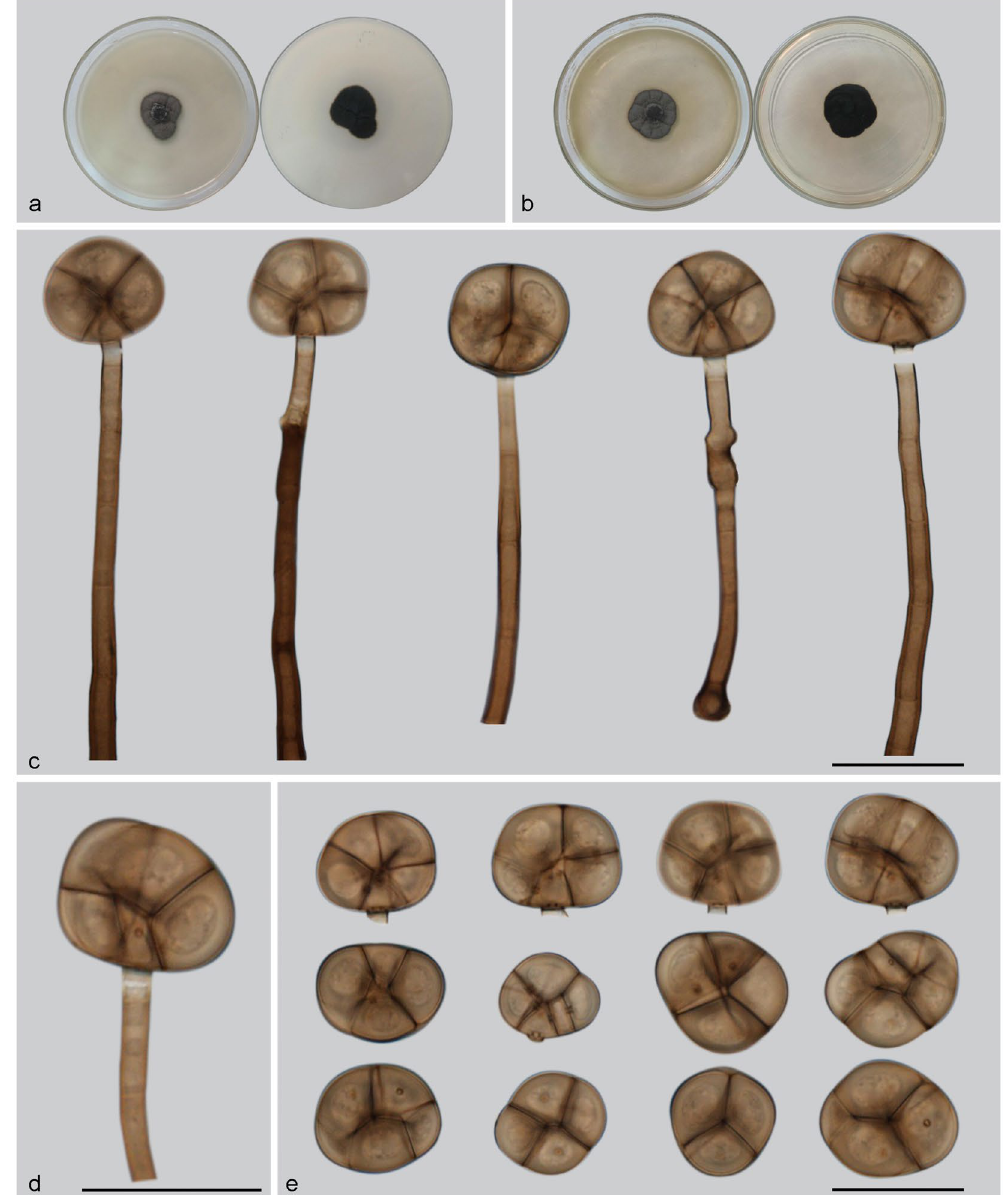
Figure 13. Distoseptispora martini. ( a ) Colony on PDA (surface and reverse). ( b ) Colony on MEA (surface and reverse). ( c – e ) From natural substrate (HSAUP H4280): ( c ) Conidiophores with conidia, ( d ) Conidiogenous cells with conidia. ( e ) Conidia. — Scale bars = 20 μ